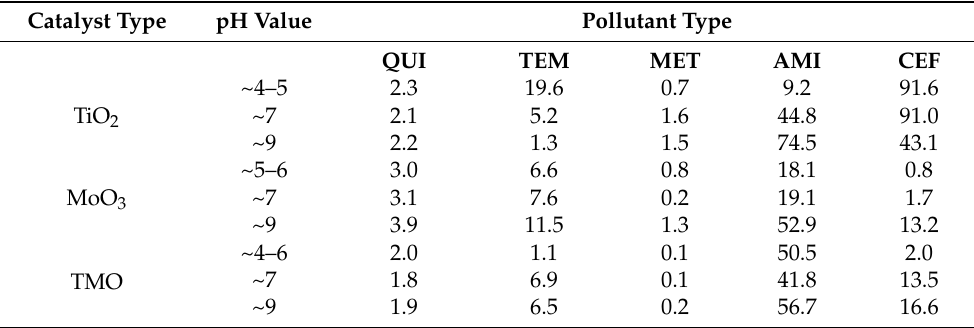
Table 2. Percentage of pollutants (0.05 mmol/dm 3 ) adsorption after reaching adsorption–desorption equilibrium on the catalyst surface (1.0 mg/cm 3 ) after 90 min of stirring in the dark.